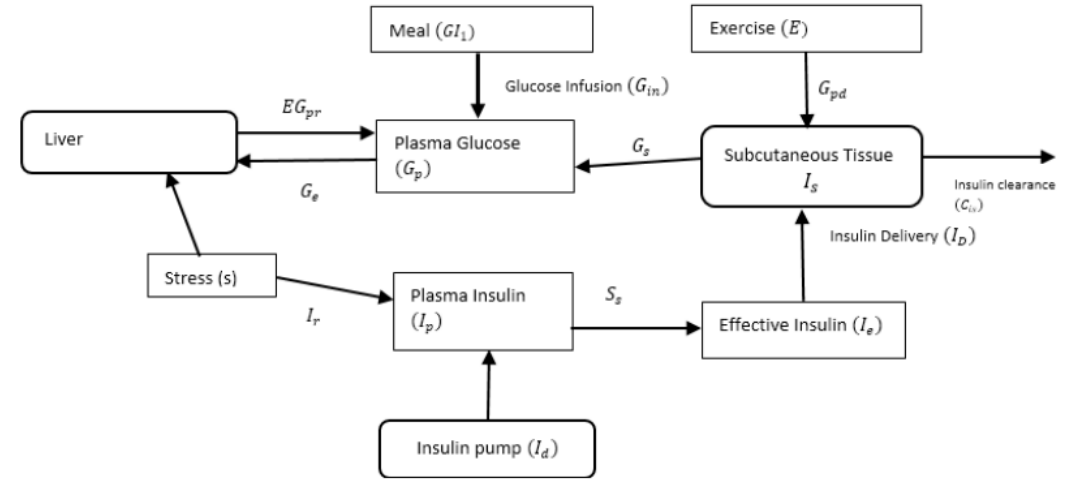
Figure 1. Modified Bergman Minimal Model.